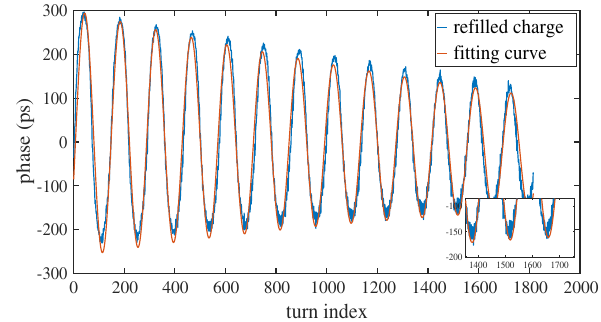
FIG. 8. The refilled charge phase and the fitting curve. Blue line: the refilled charge phase; orange line: the fitting curve of the refilled charge